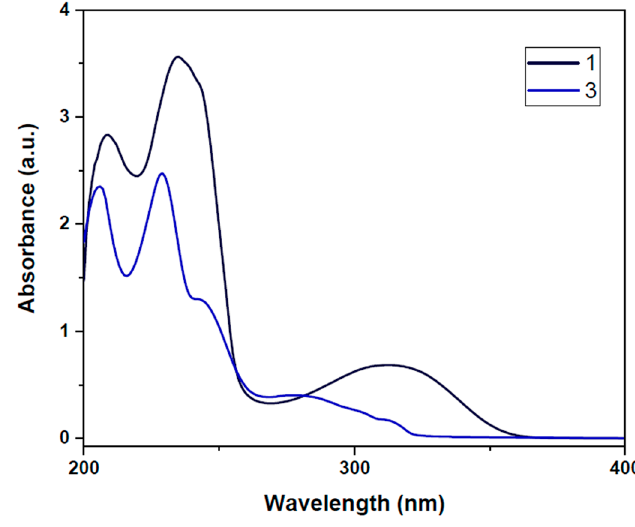
Figure 3. UV–Vis spectra of 8-hydroxyquinoline ( 1 ) and quinolin-8-yl 4-chlorobenzoate ( 3 ). Table 4. UV–Vis data of 8-hydroxyquinoline ( 1 ) and quinolin-8-yl 4-chlorobenzoate ( 3 ) in methanol solution (50 µM).